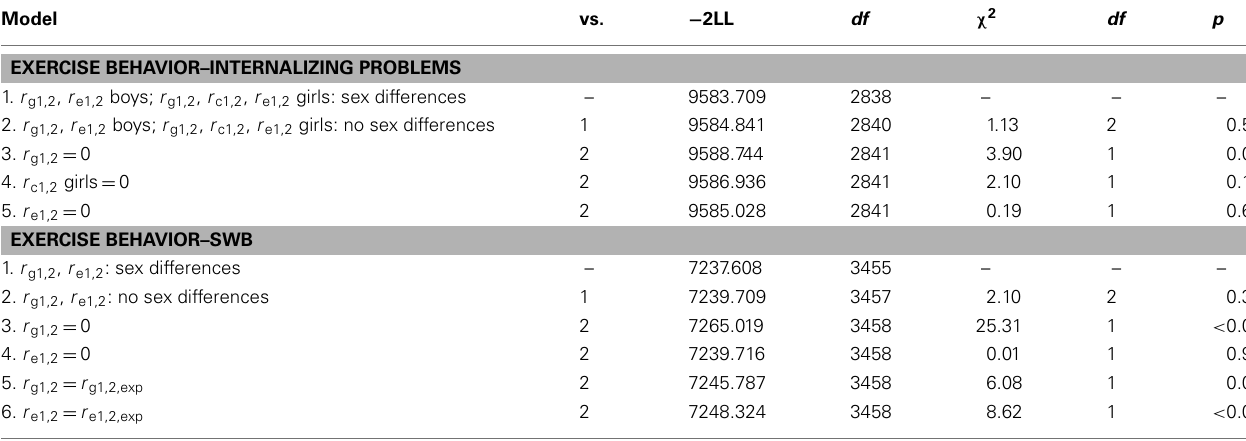
Table 5 | Longitudinal bivariate model fitting results for exercise behavior and internalizing problems and